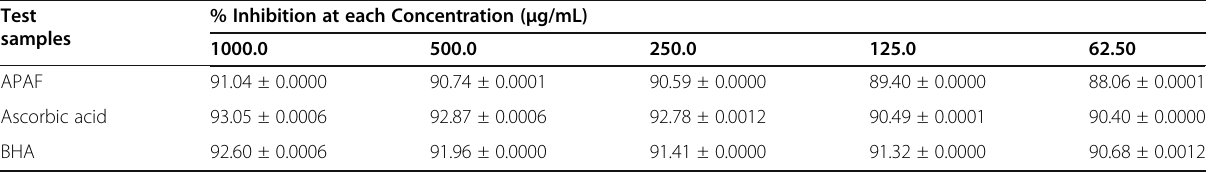
Table 2 Antioxidant Activity of the leaves essential oil of A. flagellaris showing % Inhibition at different concentrations and reference standard Test